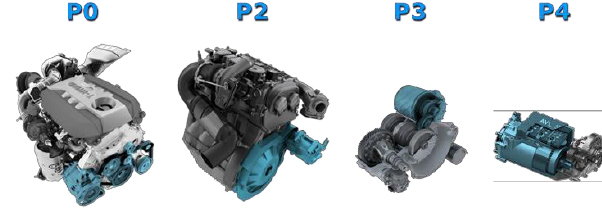
Fig. 8. Electrification of ICE-based powertrain